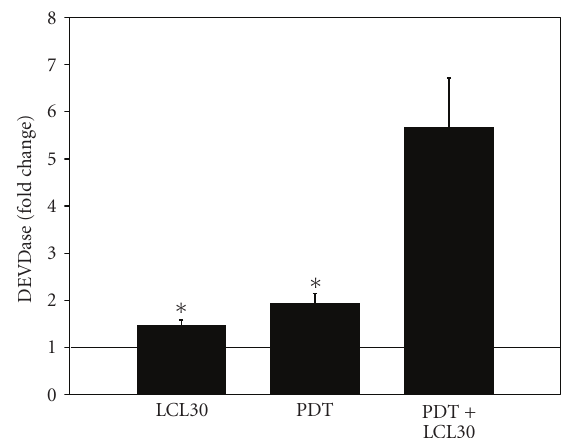
Figure 5: DEVDase activation is enhanced after (PDT+LCL30). Following incubations (see Figure 2 legend), cells were collected, cell lysates were prepared, and DEVDase activity was measured using DEVD-AMC as the fluorogenic substrate. The data are expressed as fold changes, that is, ratios of treated versus untreated controls and are shown as average ± SEM from four to six independent determinations. The significance ( P < . 05) is shown by an asterisk indicating significant di ff erence between an individual treatment, LCL30 or PDT, and the combination (PDT+LCL30).